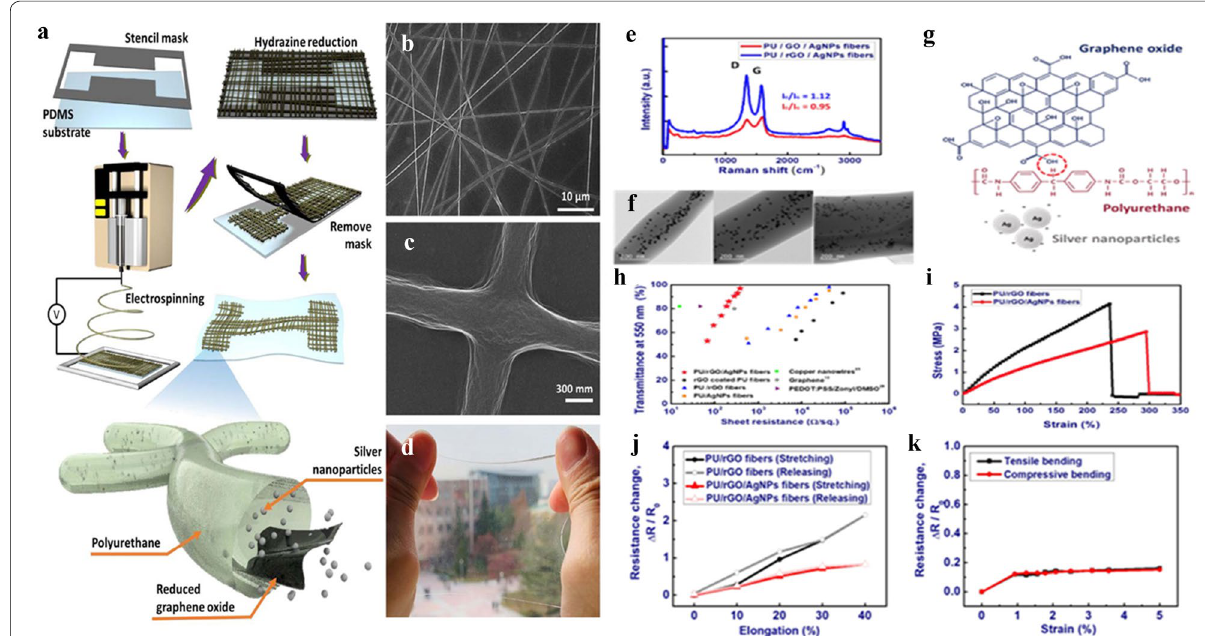
Fig. 3 a Technological flow chart of the patterned STNNE. b FESEM image of the networked nanofibers. c FESEM image of the intersections of the nanofibers. d Optical photographs of the stretchable and transparent networked nanofibers film. Dispersion of PU/rGO/AgNPs in nanofibers. e Raman spectra of PU/GO/AgNPs nanofiber and PU/rGO/AgNPs nanofiber samples with a GO:AgNPs loading ratio of 1:1.25. f TEM images of nanofibers with diameters of ~ 290, ~ 484, and ~ 933 nm. g Schematics of the functional groups on GO, chemical structure of polyurethane, and negative surface charges of AgNPs. GO nanosheets can be hydrogen‑bonded to the PU matrix by the functional moieties of the carboxyl and hydroxyl groups. h Optical transmittance‑sheet resistance of the networked nanofibers for different types of nanofibers: rGO‑coated PU, PU/rGO, PU/AgNPs, and PU/rGO/AgNPs nanofibers with that of copper nanowires, PEDOT: PSS/Zonyl/DMSO and graphene. i Stress–strain curves of PU/rGO and PU/rGO/AgNPs nanofibers. Evaluation of STNNEs under stretching conditions. j Resistance change ( ΔR/R0 ) versus elongation of the PU/rGO